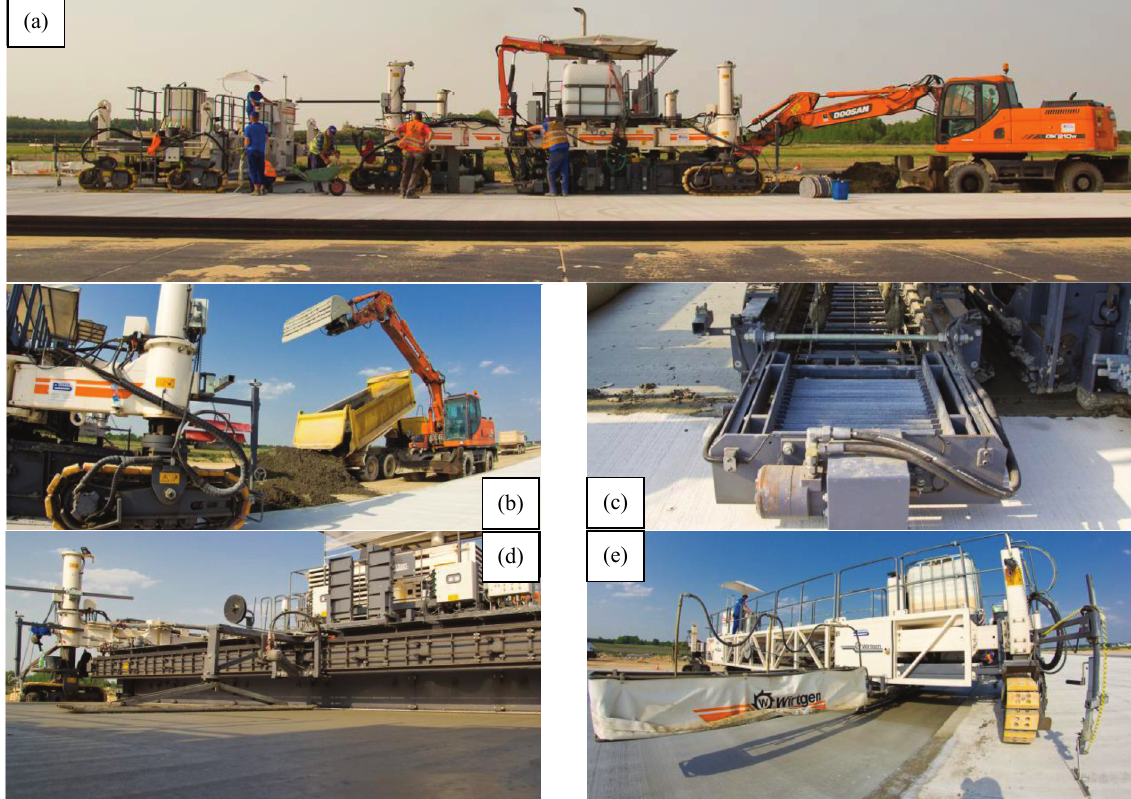
Fig. 6. Construction of a concrete abrasive layer of runway in Pyrzowice, (a) view of 3 parts of band laying machine and excavator, and consecutive concrete laying phases: (b) concrete mix supplied for preliminary spreading with the excavator, (c) element of second part of the spreader placing dowels at the width of the band made, (d) waterproof layer sprinkling system, – view of laying the second band of abrasive surface [own study, on the basis